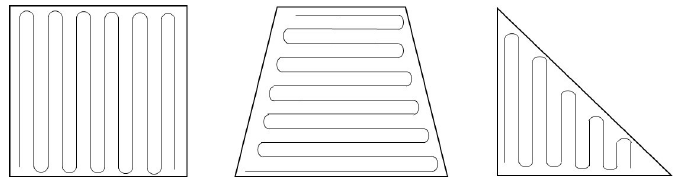
Figure 1. Examples of coverage paths on convex